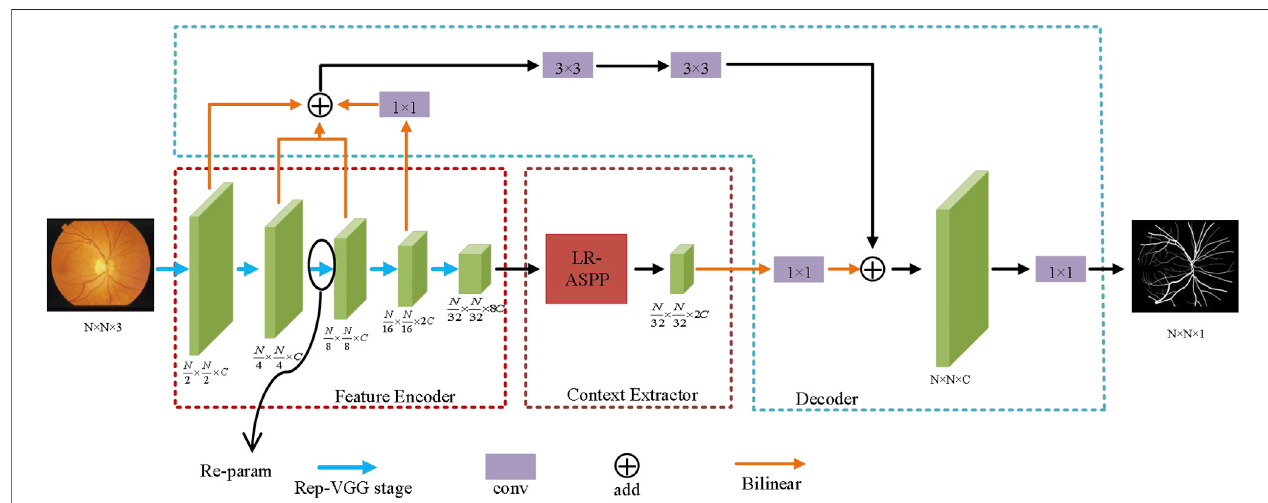
FIGURE 1 | The structure of AL-Net. After the training of AL-Net, each RepVGG block in the encoder is processed by reparameterization technology, so as to improve the inference ef fi ciency of AL-Net.